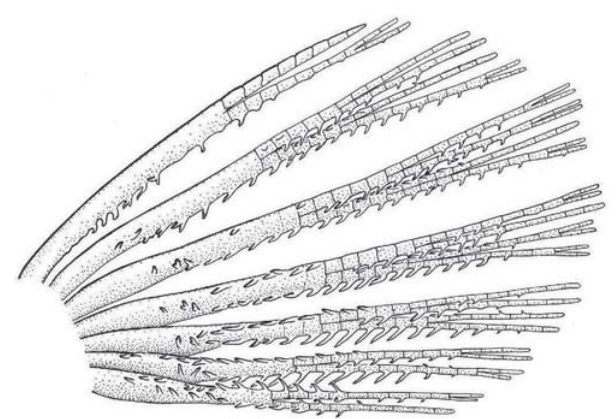
Fig. 34. Mimagoniates inequalis , adult male, MCP 9892, 37.0 mm SL; pelvic-fin rays, ventral view, left